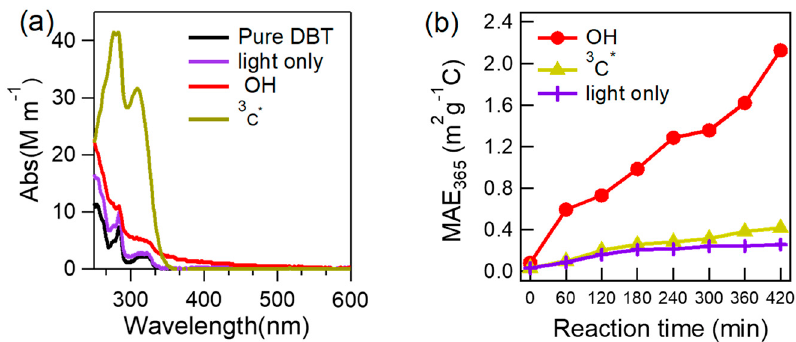
resolved factors).